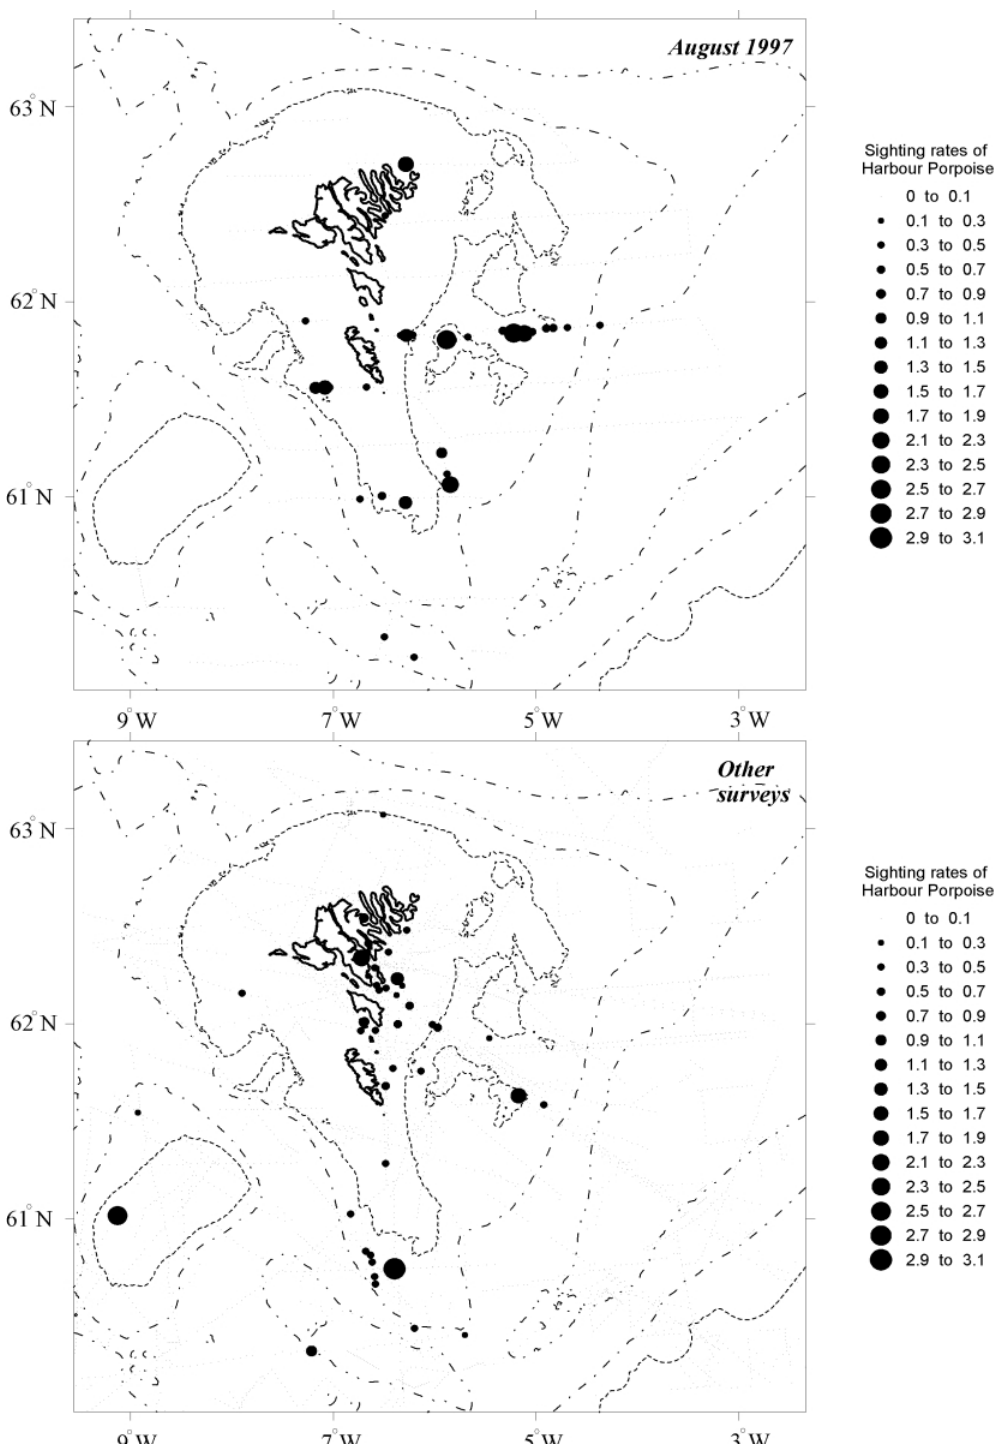
Fig. 3. The distribution of sightings (encounter rates – no./km -1 ) of harbour porpoises in sea states 0-2 during the survey in August 1997 and during the remaining surveys made between May and September 1987-1999. The 100 m, 300 m and 1000 m depth contours are